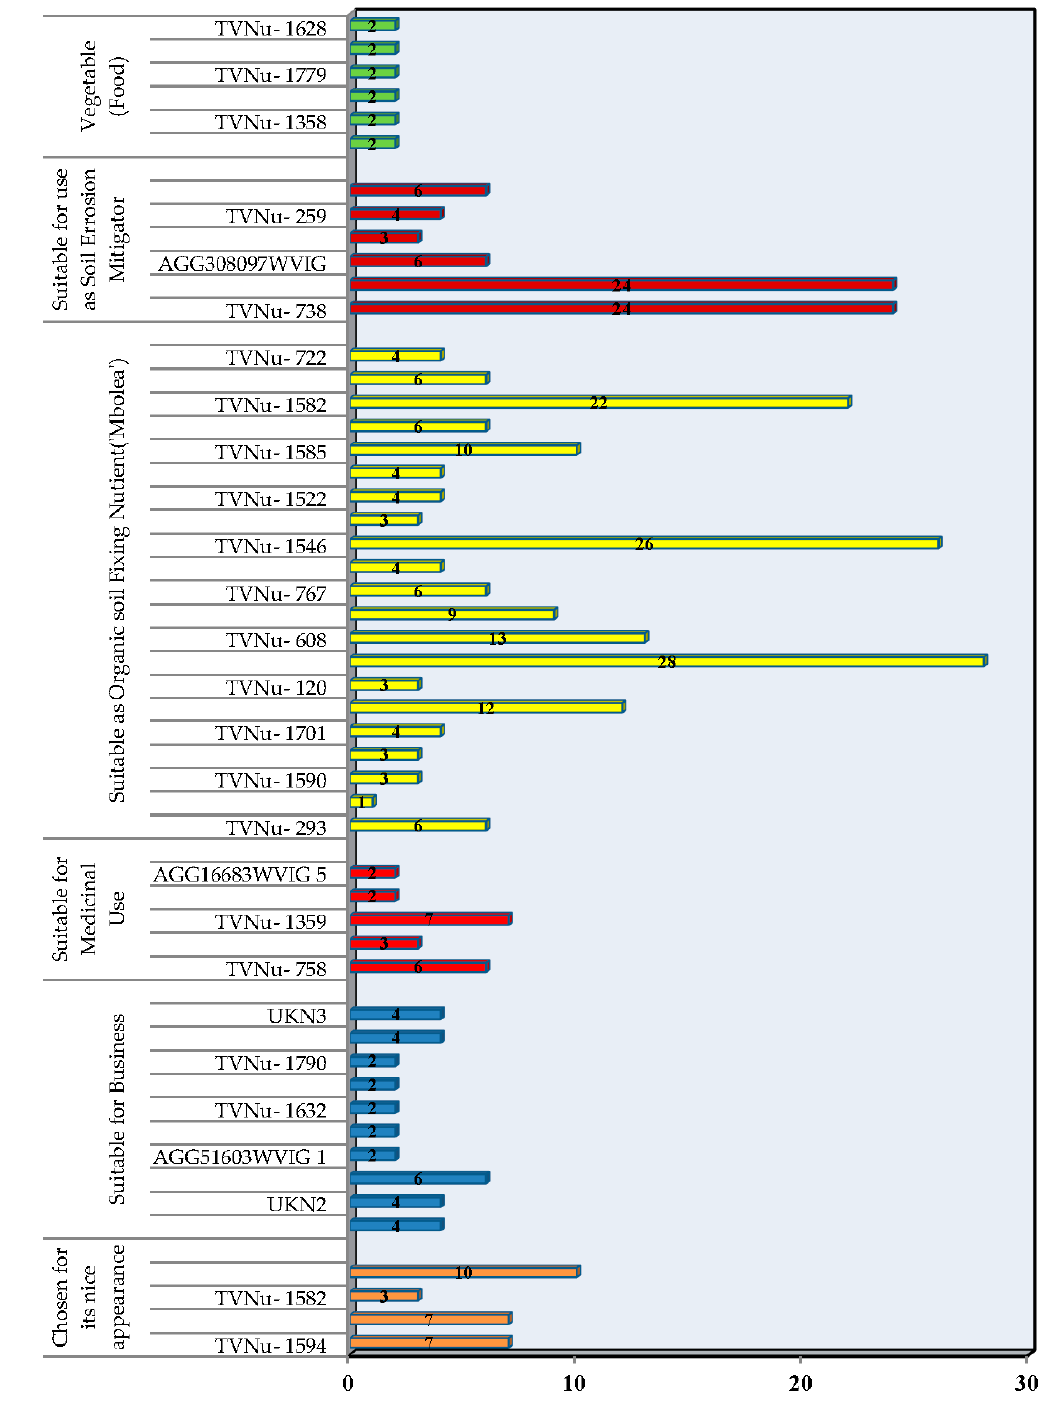
Figure 9. Specified uses of wild Vigna legumes as proposed by farmers in the two agro-ecological zones of